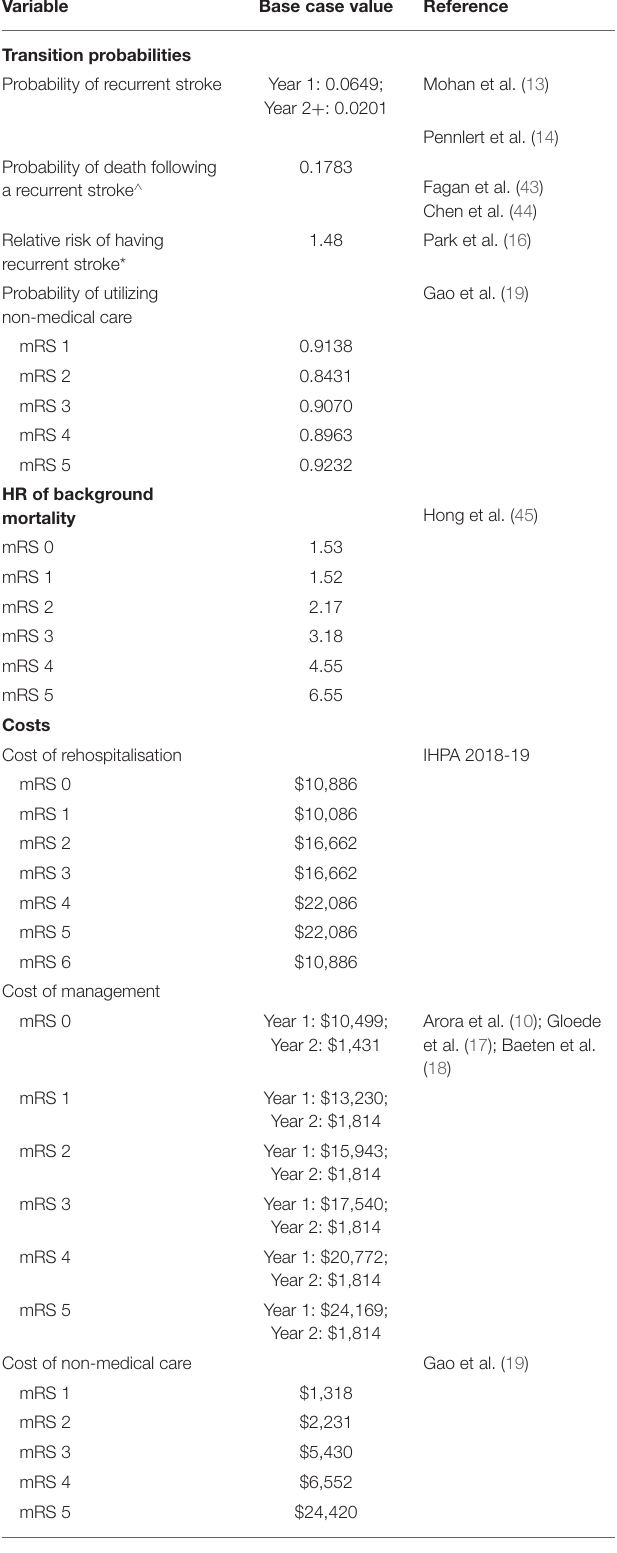
TABLE 1 | Inputs for the long-term cost-effectiveness analysis.